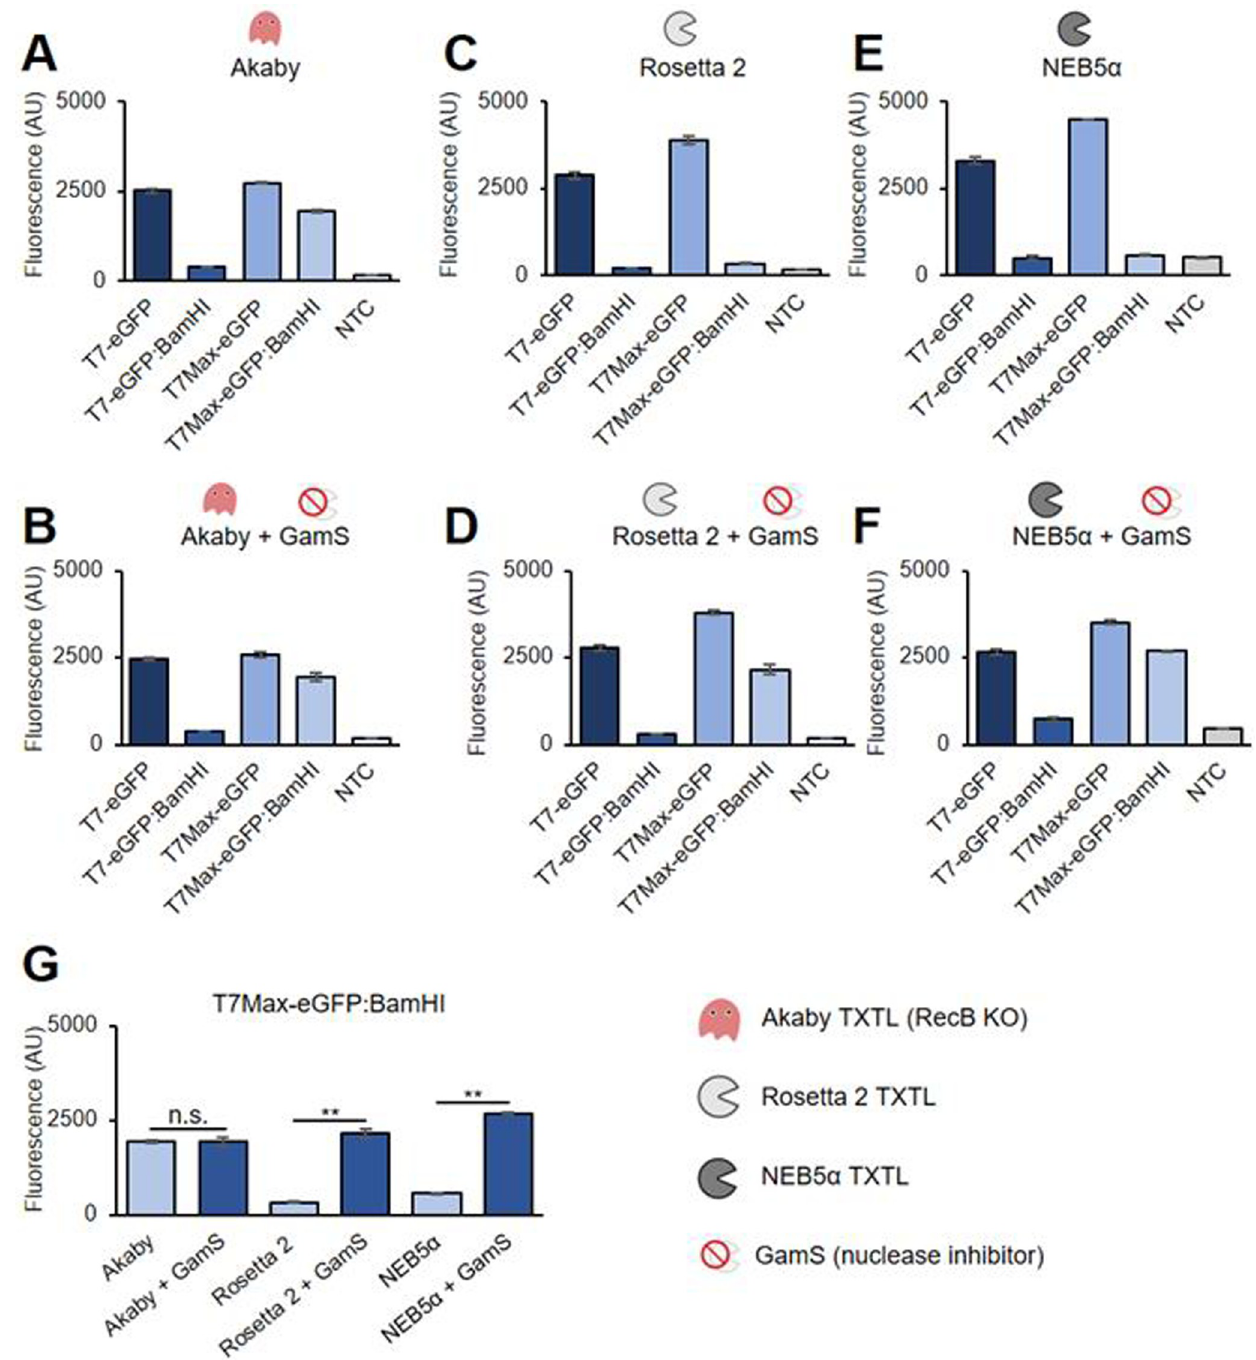
Fig 2. eGFP expression comparison between Akaby, Rosetta 2, and NEB5 α TXTL. TXTL reactions were performed with eGFP templates (5 nM) for 8 hours at 30˚C, and each fluorescence was measured at λ ex 488 nm and λ em 509 nm. The eGFP expression in (A) Akaby TXTL, (B) Akaby + Gams TXTL, (C) Rosetta 2 TXTL, (D) Rosetta 2 + GamS TXTL, (E) NEB5 α , and (F) NEB5 α + GamS. GamS (3.5 μ M) was supplemented as a nuclease inhibitor. (G) The TXTL reaction comparison for eGFP fluorescence was generated with the T7Max-eGFP:BamHI template data. T7, the T7 RNA polymerase promoter; T7Max, the enhanced T7 RNA polymerase promoter; template named with BamHI, linearized plasmids by BamHI; NTC, no template control. The graphs show means with error bars that signify SEM (n = 3). Significance was determined by Student’s t-Test. �� p < 0.01.